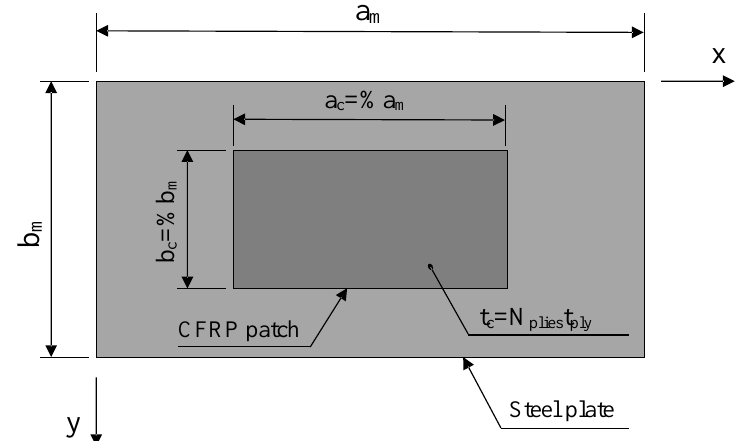
Figure 9. Design schematic of a rectangular composite patch applied to a metal plate.